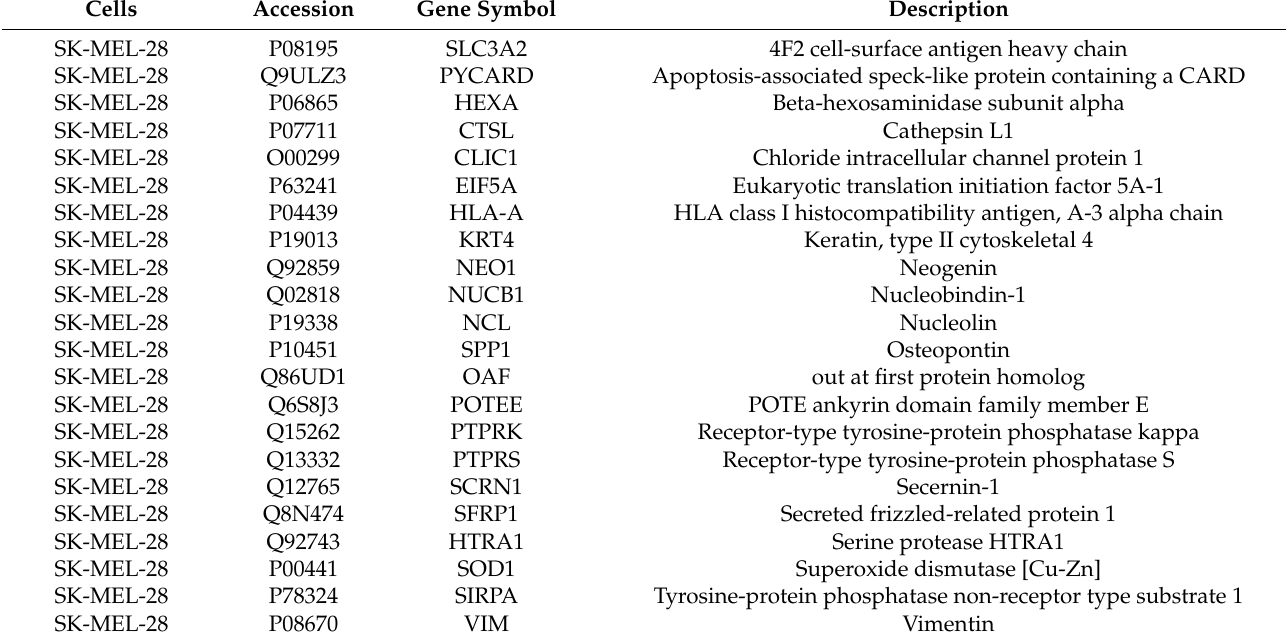
Table 1. Specific (differentially expressed) proteins of parental and resistant cells.